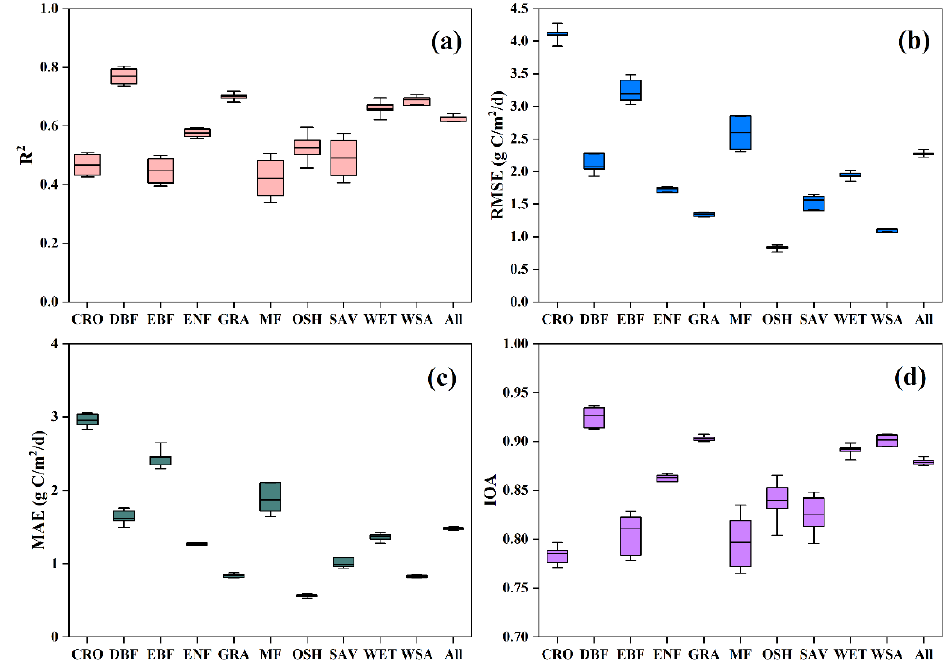
Figure 6. 10-fold cross validation of the model driven by ERA5 meteorological data for different vegetation types, using (a) the coefficient of determination (R 2 ), (b) the root-mean-square error (RMSE) (gC/m 2 /d), (c) the mean absolute error (MAE) (gC/m 2 /d), and (d) the index of agreement (IOA) as the accuracy evaluation indices. The vegetation types include cropland (CRO), closed shrubland (CSH), deciduous broadleaf forest (DBF), deciduous needleleaf forest (DNF), evergreen broadleaf forest (EBF), evergreen needleleaf forest (ENF), grassland (GRA), mixed forest (MF), open shrubland (OSH), savanna (SAV), permanent wetland (WET), and woody savanna (WSAV).